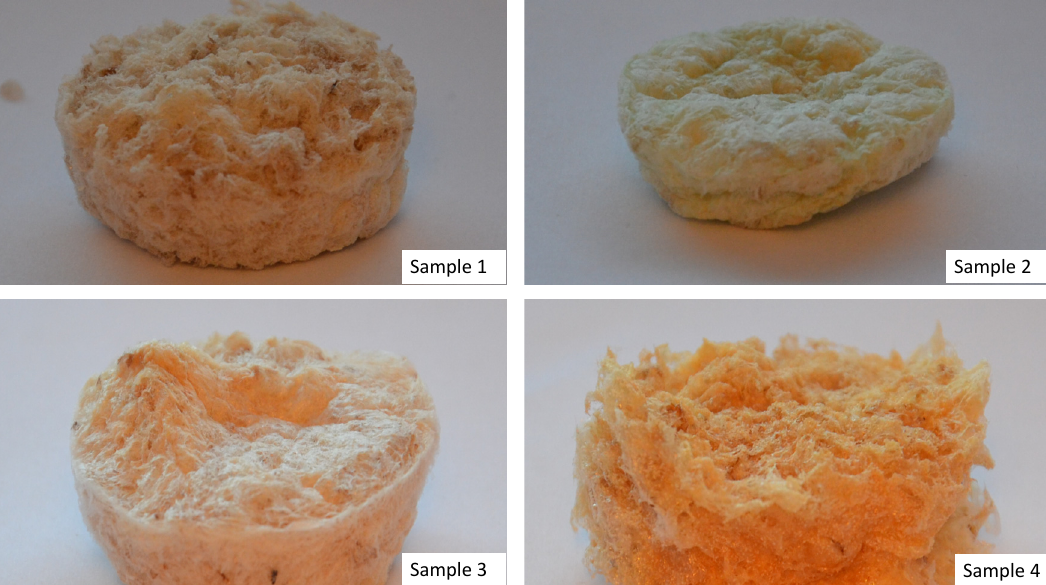
Sample 4Sample 3